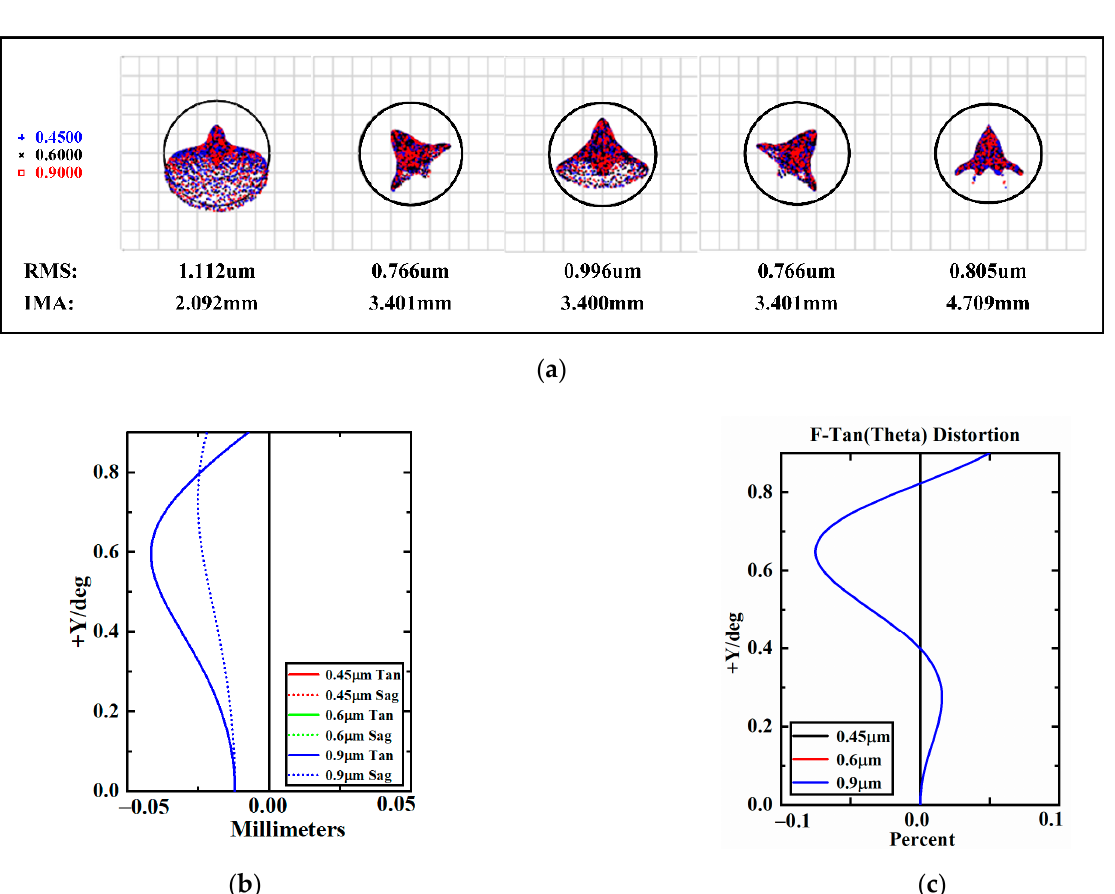
Figure 8. ( a ) Spot diagram of the rear-polarization system. ( b ) field curvature of the different wavelengths. ( c ) distortion of the different wavelengths.